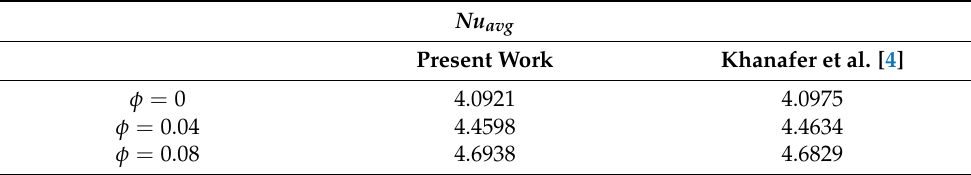
(cid:0) (cid:1) Nu avg Table 2. Comparison of the average Nusselt number Table 2. Comparison of the average Nusselt number (𝑁𝑢 (cid:3028)(cid:3049)(cid:3034) ) with the results of Khanafer et al. [4] with the results of Khanafer et al. [4] for various nanoparticles’ volume fractions at Pr = 6.2 and Ra = 6.2 × 10 4 . for various nanoparticles’ volume fractions at Pr = 6.2 and Ra = 6.2 × 10 4 . 𝑵𝒖 𝒂𝒗𝒈 Nu avg Present Work Present Work Khanafer et al. [4] 𝜙 = 0 φ = 0